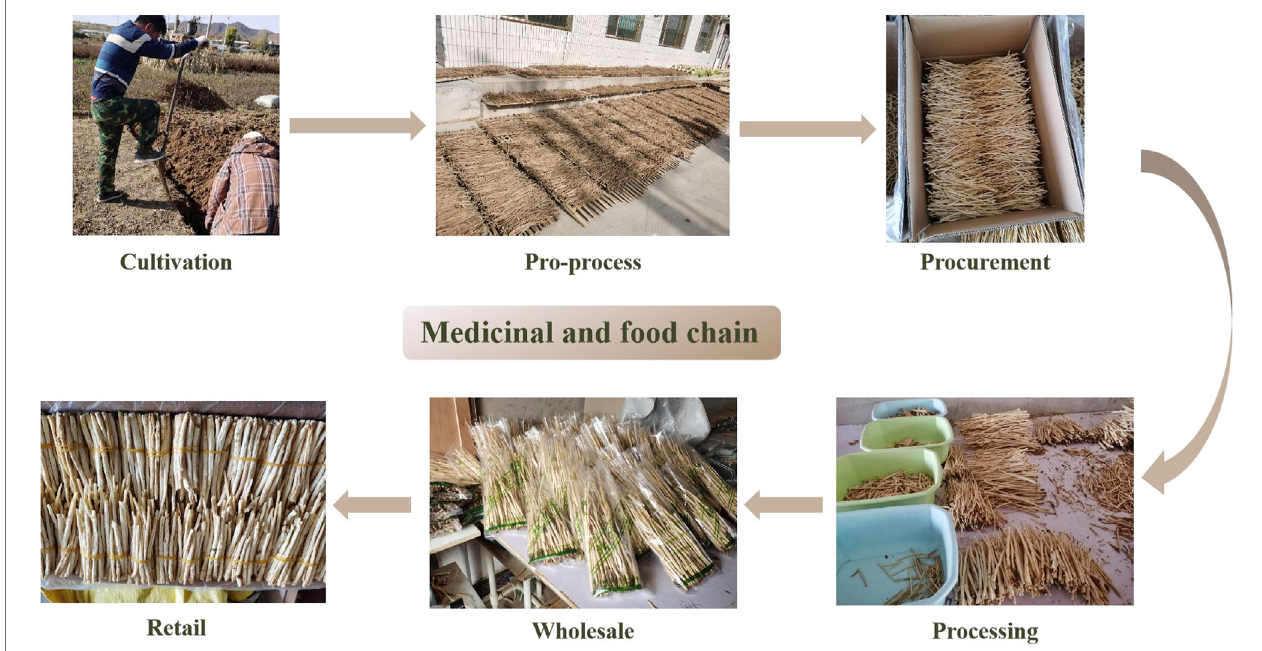
FIGURE 2 | The six stages of GR pathway in the medicinal and food